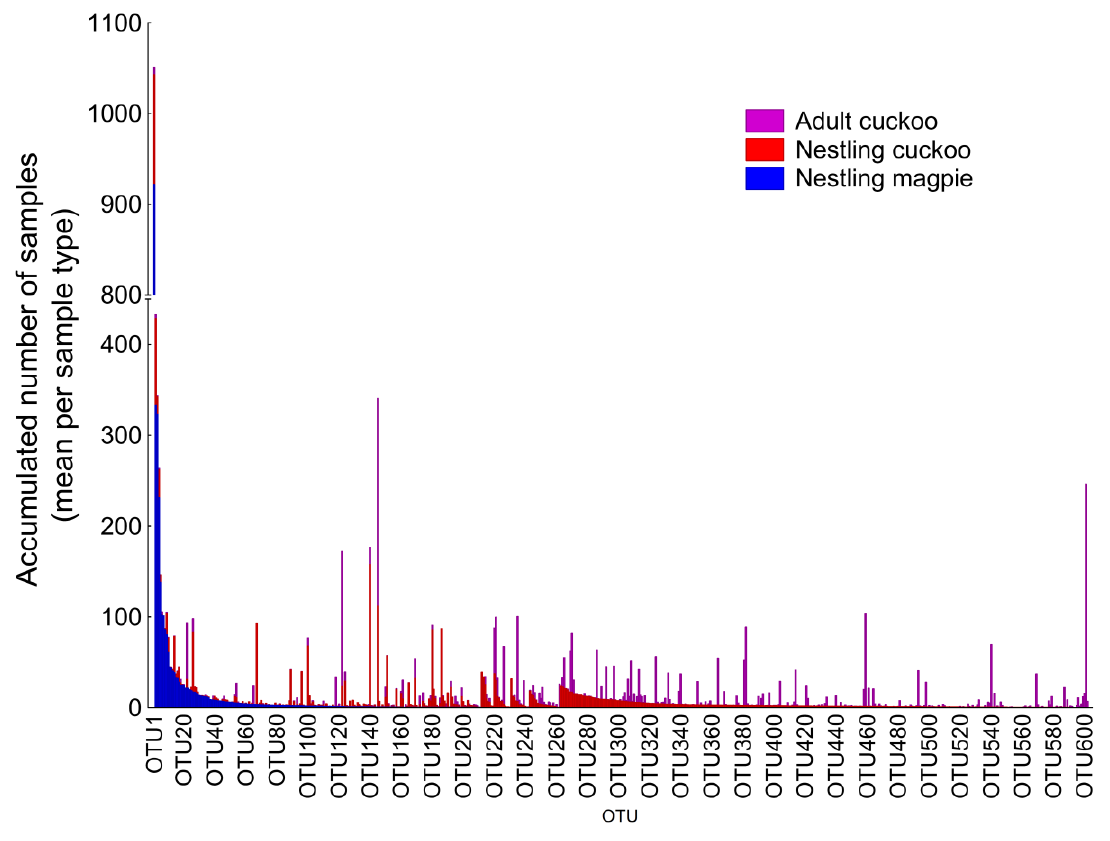
Figure 1. Differences in the abundance of the different Operational taxonomic Units (OTUs) (mean number of sequences per sample) in the cloaca of magpie nestlings, cuckoo nestlings, and cuckoo adults. Bars represent the accumulated number of sequences and OTUs are ordered by their abundance in magpies, and afterward in nestling cuckoos. Only OTUs with at least 25% of prevalence in any sample type are considered.